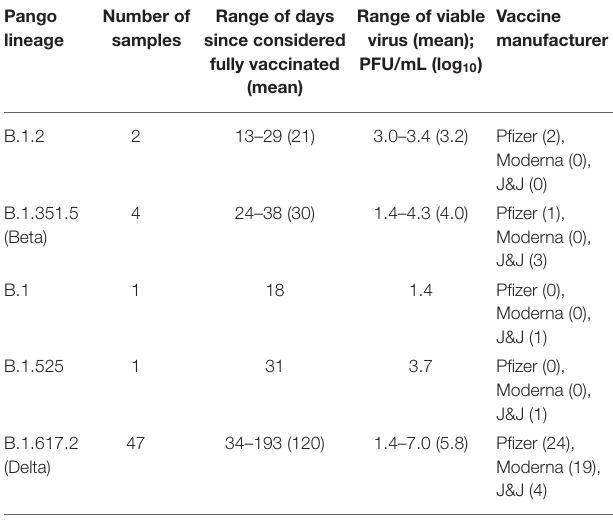
TABLE 2 | Summary of viable virus detection in nasal swab samples from vaccinated individuals broken down by Pango lineage. Pango